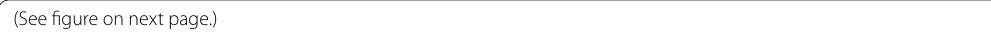
figure on next Fig. 2 LncARAT upregulates CCL2 expression in SCs and promotes H3K4me3 at the CCL2 promoter by interacting with KMT2A. A Western blot and quantitative analysis of CCL2 expression in injured nerves 4 dpi (n 5). B IF assay of CCL2 (green) and S100β (red) in injured nerves 4 dpi after = lncARAT overexpression or knockdown. Scale bar, 50 µm. C Western blot and quantitative analysis of CCL2 expression in primary SCs after lncARAT overexpression for 48 h (n 3). D Sequential deletions of the CCL2 promoter linked to Renilla luciferase were constructed and then transfected into = SCs to assess their transcriptional activity 48 h later. E Left panel, schematic presentation of the potential lncARAT binding sites in the CCL2 promoter. Right panel, ChIRP assessment of lncARAT-associated chromatin in SCs. F Genomic neighborhood of CCL2. Genome browser tracks from the UCSC genome browser showing H3K4me3 occupancy near CCL2. G IF assay of H3K4me3 levels (green) and S100β levels (red) in injured nerves 4 dpi after lncARAT knockdown. Scale bar, 50 µm. H RNA pulldown followed by western blot analysis of KMT2A, KMT2B, and KMT2D in SCs. I RIP assay using anti-KMT2A, KMT2B, or KMT2D antibodies in SCs. U1 was used as the negative control. ChIP analyses using KMT2A antibody ( J ) and H3K4me3 antibody ( K ) on the regulatory regions of CCL2 genes in SCs 72 h after lncARAT overexpression. * p < 0.05. ** p <